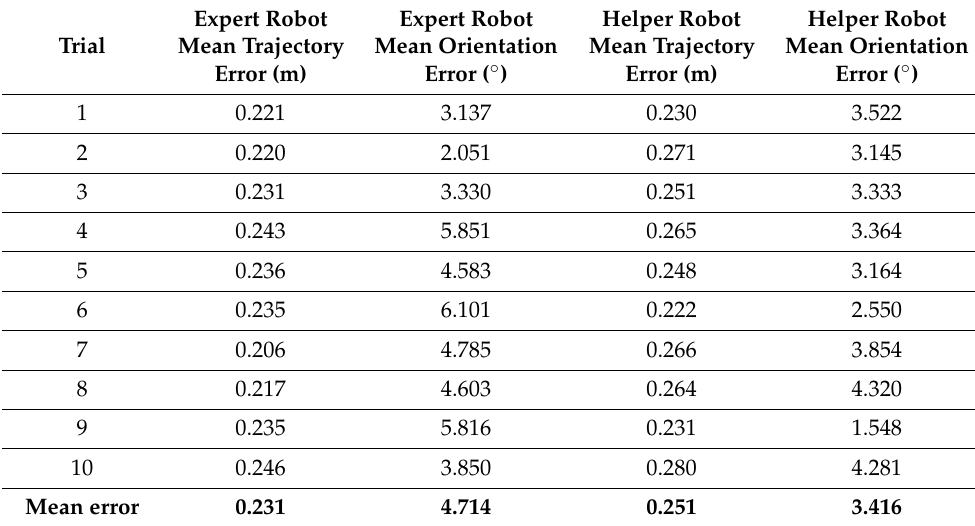
Table 5. Average position and orientation errors for the expert and helper robots for the second test path.